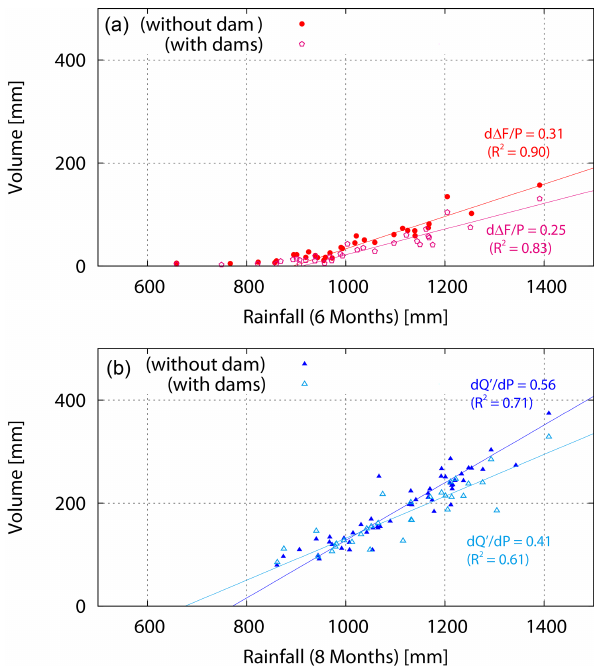
Figure 8. (a) Relationship between cumulative rainfall ( P ) for 6 months and peak inundation volumes ( (cid:49)F ) with and without dams. (b) Relationship cumulative between rainfall ( P ) for 8 months and cumulative runoff ( Q (cid:48) ) with and without dams. Note that for evalu- ating the cumulative runoff volumes, the period of the analysis was extended by 2 more months after the time of peak flood inundation. Since the figure shows the plots for only between 1980 and 2011 for comparison, the regression result of d (cid:49)F /d P in (a) is different from Fig. 7 and Table